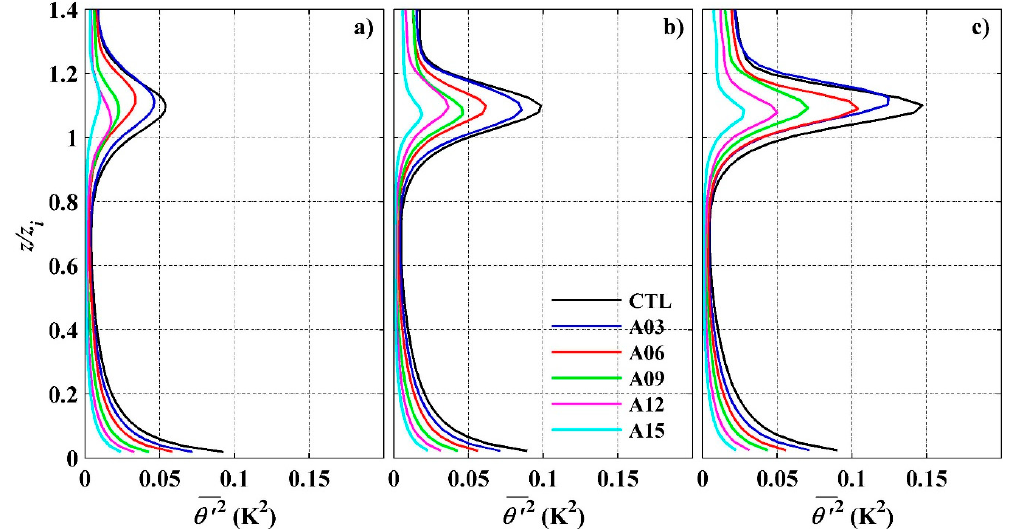
Figure 11. Profiles of potential temperature variance ( θ (cid:48) 2 ) for the cases with three different stratification strengths in the free atmosphere: ( a ) 3 K km − 1 , ( b ) 6 K km − 1 , and ( c ) 9 K km − 1 . The color scheme for cases with different AOD is the same as in Figure 8.